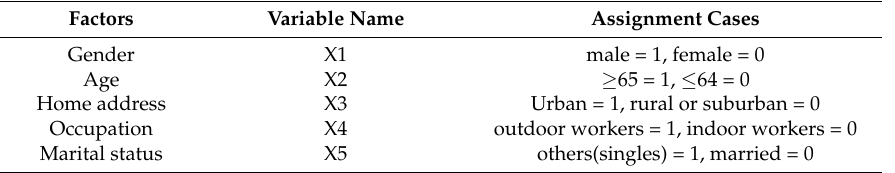
Table 2. The factors we analyzed and their assignment